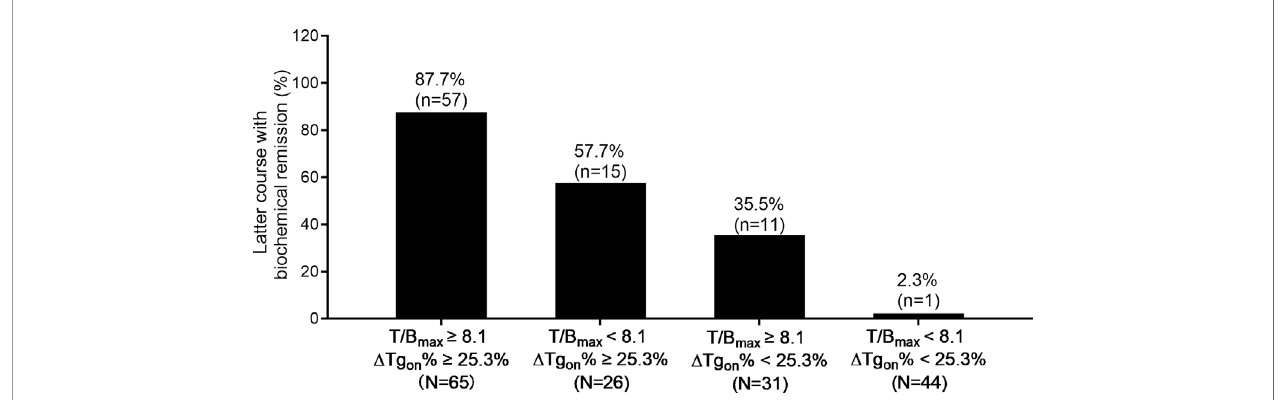
FIGURE 1 | Distribution of biochemical remission in 166 paired latter courses of RT with regard to the results of T/B max and D Tg on % obtained from the former courses. RT, radioiodine treatment; T/B max , maximum target-to-background ratio; Tg on , thyroid stimulating hormone-suppressed thyroglobulin; D Tg on %, change rate of Tg on level.